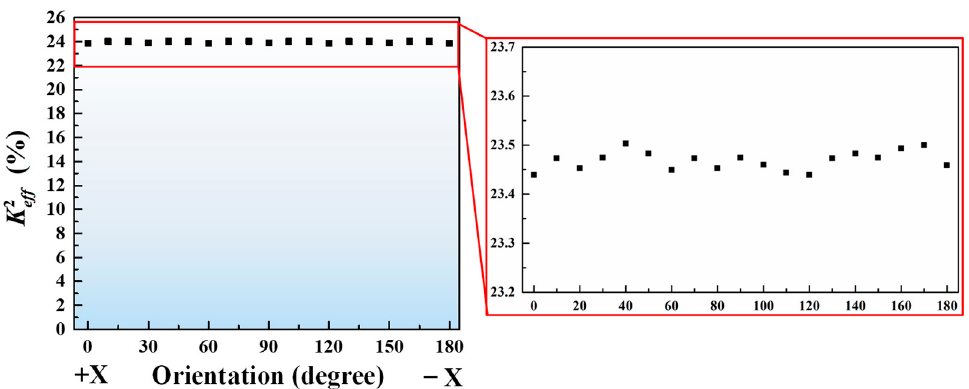
Figure 5. Calculated electromechanical coupling efficient of the A 1 mode acoustic wave in a Z-cut LiNbO3 thin film vs. the rotation angle of electrodes.